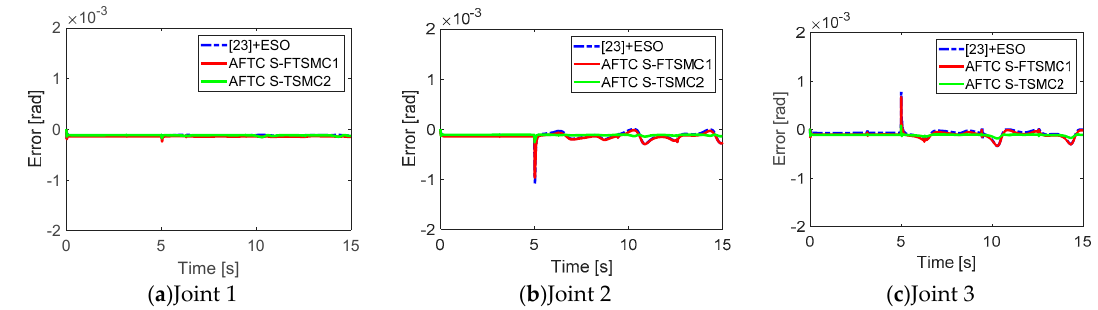
Figure 5. Tracking error at each joint with a single fault at joint 2.